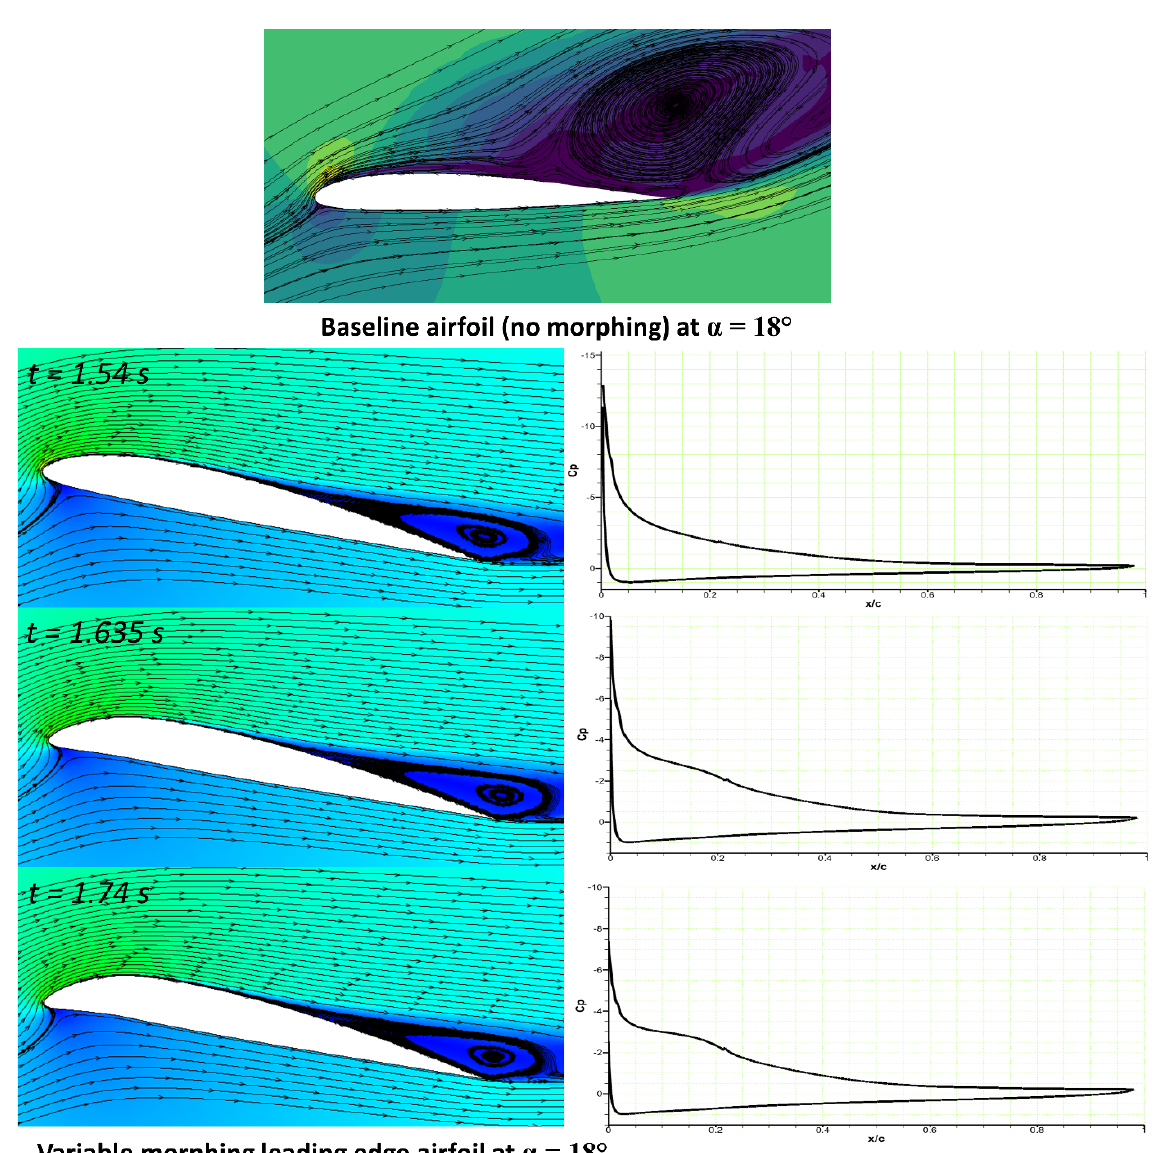
Figure 13. Streamline velocity contours at different time steps on a variable morphing leading edge and the Cp distribution at an angle of attack of 18°.